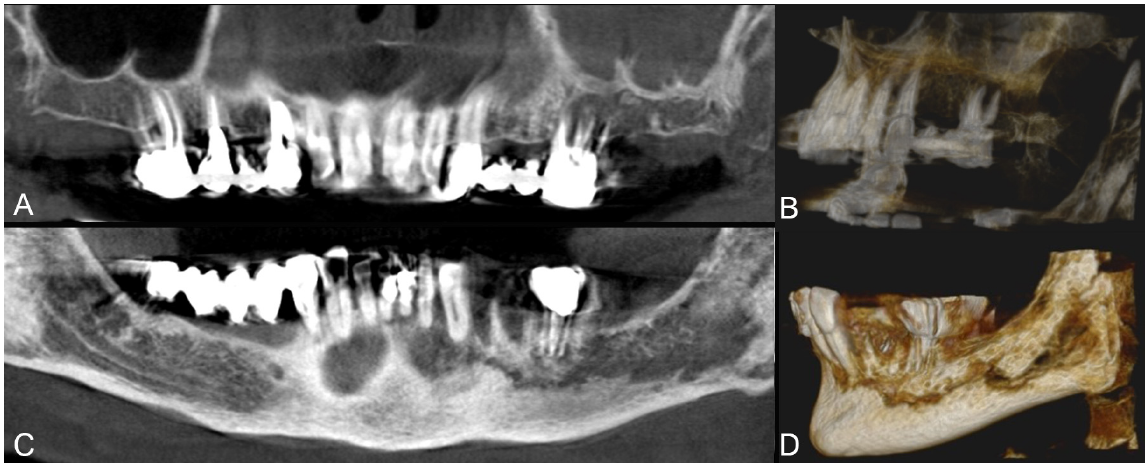
Figure 2. Group A patient. Radiological pre-operative assessment through cone beam computed tomography of a stage 2 maxillary and mandibular MRONJ. Maxillary view ( A ) and 3D reconstruction ( B ); mandibular view ( C ) and 3D reconstruction ( D